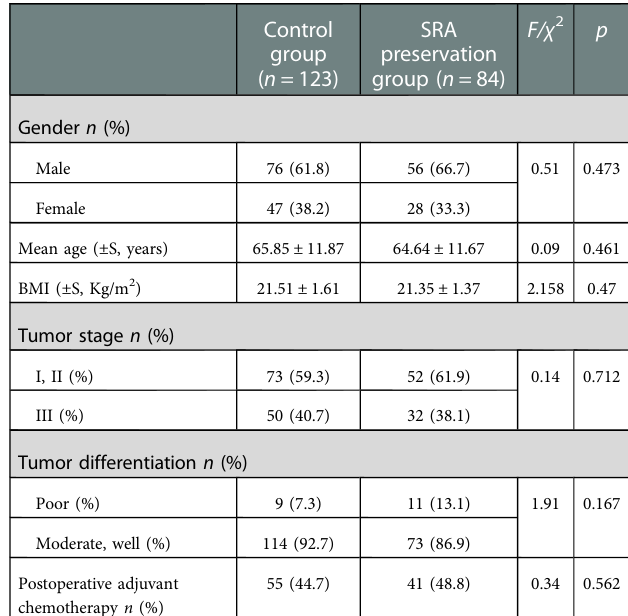
TABLE 1 Demographic and clinical